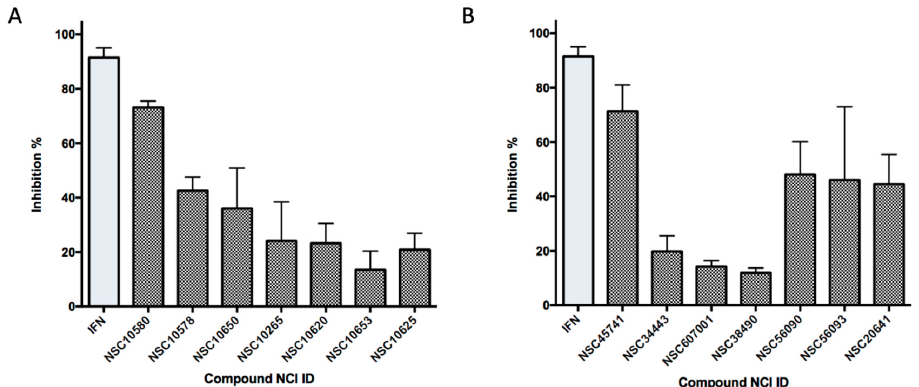
Figure 8. Inhibitory activities of derivative compounds against ZIKV infection on BHK-21 cell lines. ( A ) Inhibitory activities of Compounds 1 and 1A – 1F at a concentration of 20 µ M. ( B ) Inhibitory activities of Compounds 2 and 2A – 2F at a concentration of 50 µ M. IFN- α at 20 IU served as a positive control.